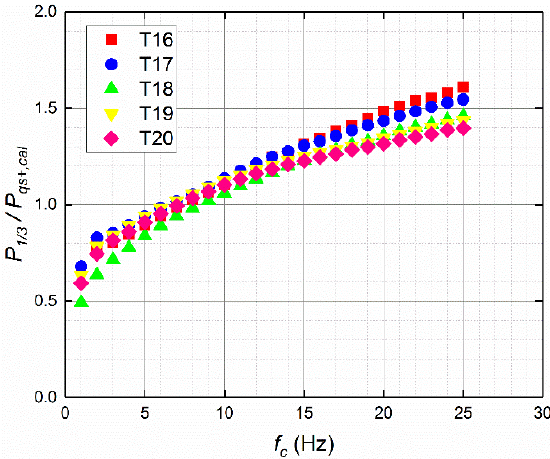
Figure 6. The ratio of the measured averaged values P 1/3 and calculated values P qs+,cal as a function of different cut-off frequencies f c for five horizontal wave plate trials.